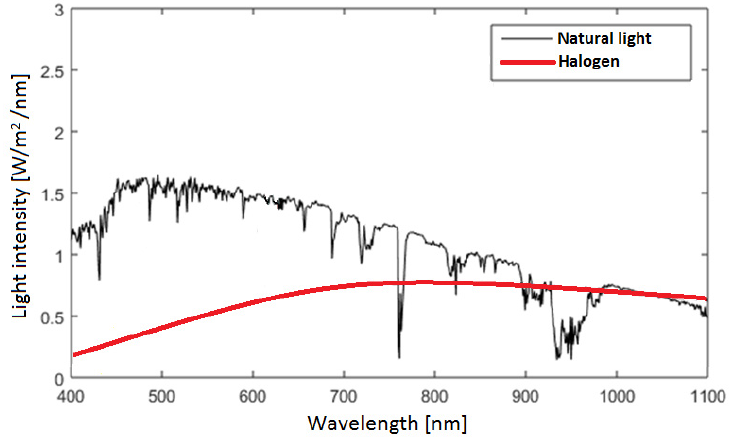
Figure 2. Difference in light intensity between natural and artificial (halogen) light.